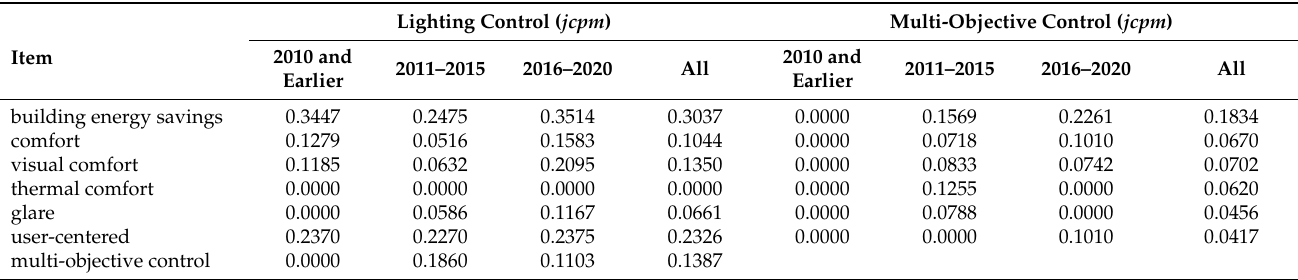
Table 6. Joint conditional probability measure ( jcpm ) of the items lighting control and multi-objective control networked with different target criteria of a building control, determined by using